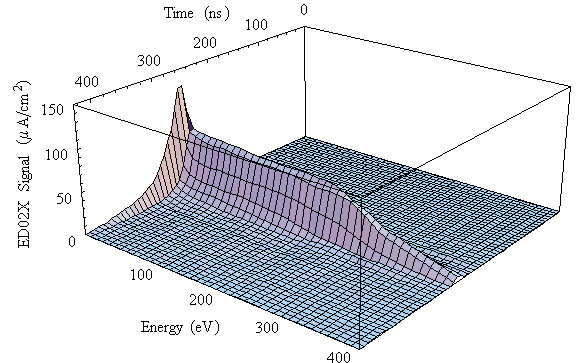
bunch.FIG. 8. (Color) Measured cumulative energy spectrum of the electrons hitting the wall as a function of time in the PSR (the origin of time corresponds to the passage of the head of the